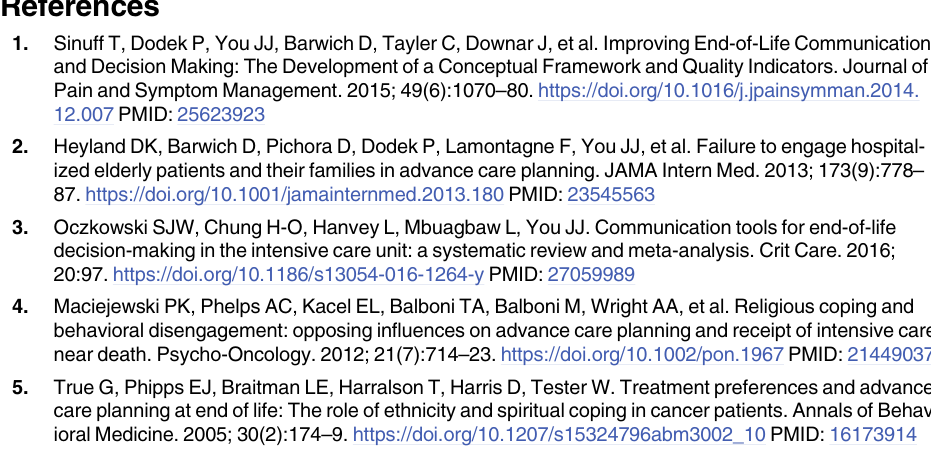
S1 Table. Characteristics of eligible studies. S2 Table. Influence of end-of-life decision-making tools on patient and family-related out- comes of